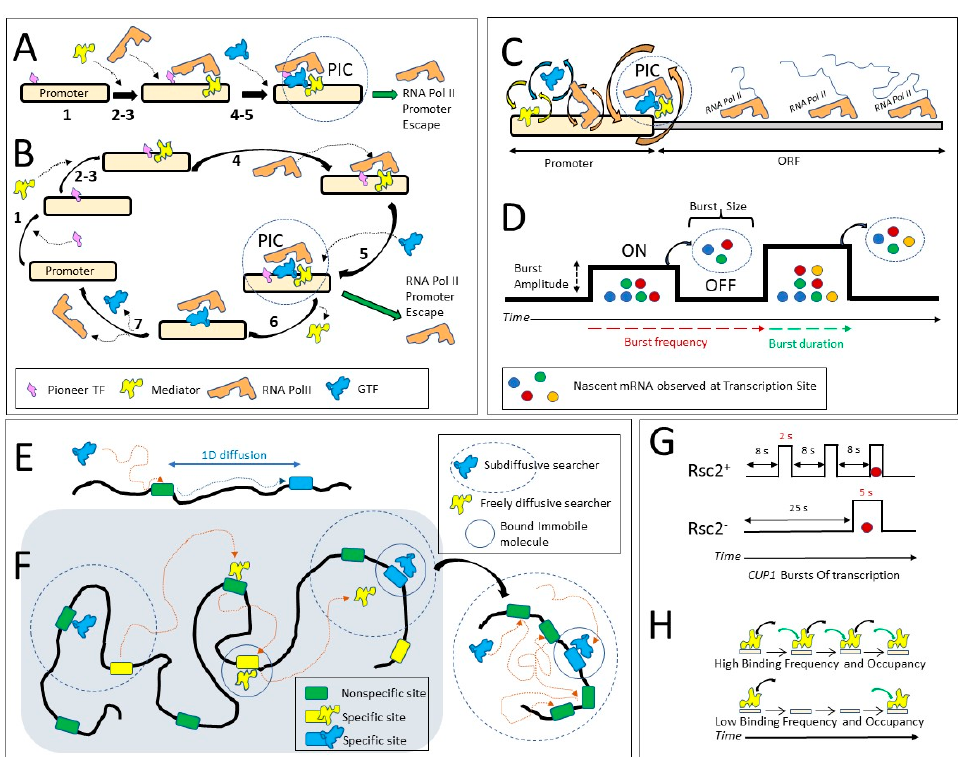
Figure 4. Lessons from SMT. ( A ) Sequential formation of PIC, based on ChIP. Steps 1–5 schematically depict sequential formation of PIC, which is then followed by RNA Pol II escape from PIC and elongation. ( B ) Schematics depict cycles of binding of pioneer factors, Mediator, GTFs, RNA Pol lI. Binding of the pioneer factor necessary for the promoter opening by chromatin remodelers is followed by multiple cycles of PIC assembly (1–5) and disassembly (6–7). Alternatively, assembly of PIC may be followed by RNA Pol II escape and elongation. ( C ) Schematics of the fast cycles of PIC formation followed periodically by RNA Pol II promoter escape and elongation; multiple polymerases may transcribe the same ORF at the same time. ( D ) Burst parameters for the gene bursting activity over time, where periods of inactivity (OFF) are followed by periods of activity (ON). In these schematics, individual molecules of mRNA presented by color-coded balls are released before the burst ends. Multiple nascent mRNAs may be present at the same ORF, as depicted by the simultaneous presence of two balls of different colors for the first burst or three for the second burst. ( E ) Schematics of 1D diffusion. Protein binds to the nonspecific site and proceeds to specific sites by sliding along the DNA. ( F ) Nuclear space exploration by proteins searching for specific sites (yellow for yellow molecule, blue for blue molecule) and sampling nonspecific sites (green). Non-compact non-constrained searchers move by isotropic diffusion, explore relatively large areas, and perform non-redundant search, leaving many targets unsampled (yellow molecule). Zones of restricted mobility to which proteins may be confined (blue molecule of the cartoon) are designated by dashed circle lines. Compact searchers (blue molecule) sample multiple binding sites performing redundant search as depicted in magnified constrained area pointed to by arrow. ( G ) RSC complex is necessary for high frequency of Ace1p binding and for the reduction of Ace1p residence time at CUP1 promoter. Burst dynamics over time are represented by black line. Red circle represents nascent mRNA at the promoter. ( H ) High binding frequency (TF on, green arrow; TF off, black arrow) leads to high time-averaged occupancy of the promoter over time by TF (yellow molecule) (Top). Low binding frequency leads to low time-averaged occupancy